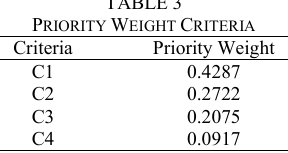
TABLE 3 P RIORITY W EIGHT C RITERIA